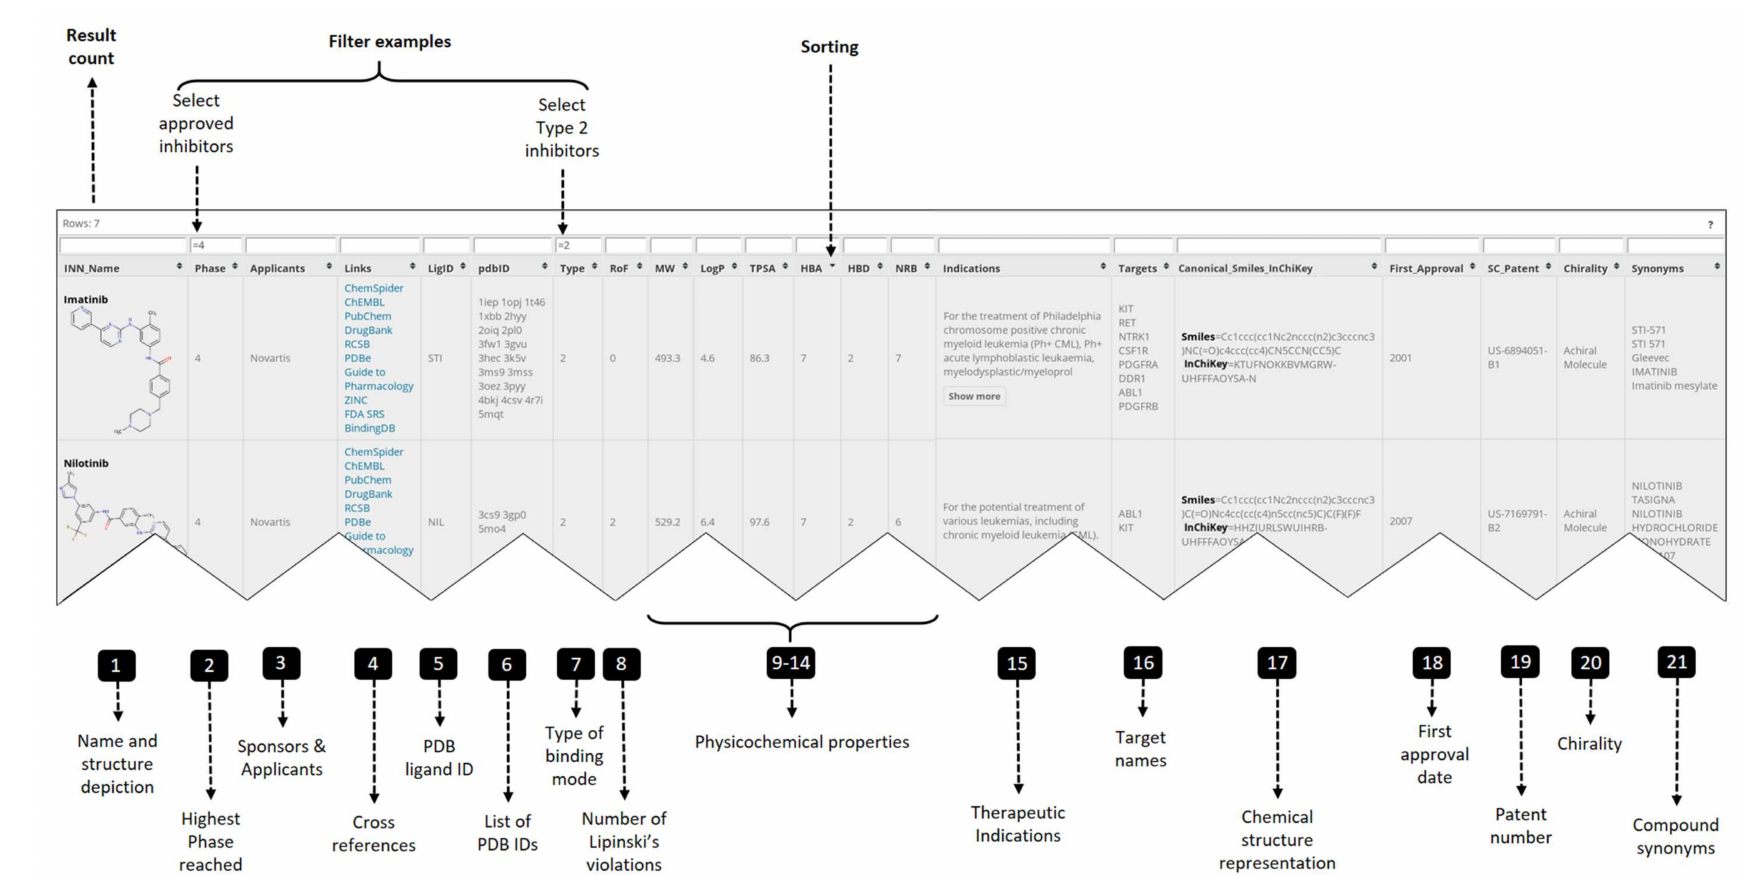
Figure 3. Overview of the PKIDB interface: Available data for each inhibitor are summarized over twenty-one columns. Filters above each column are provided to facilitate data visualization. Advanced searches can be performed by using operators and expression. Numerical <, ≤ , >, ≥ , =; String match =, *, !, {, }; Logical operator || (OR), && (AND). After filtering, the number of the remaining inhibitors is displayed in the top left corner. All fields of the table are sortable (alphabetically, numerically or both) by clicking on the column header ( (cid:7) ). In the first column, image upscaling is triggered by mouse